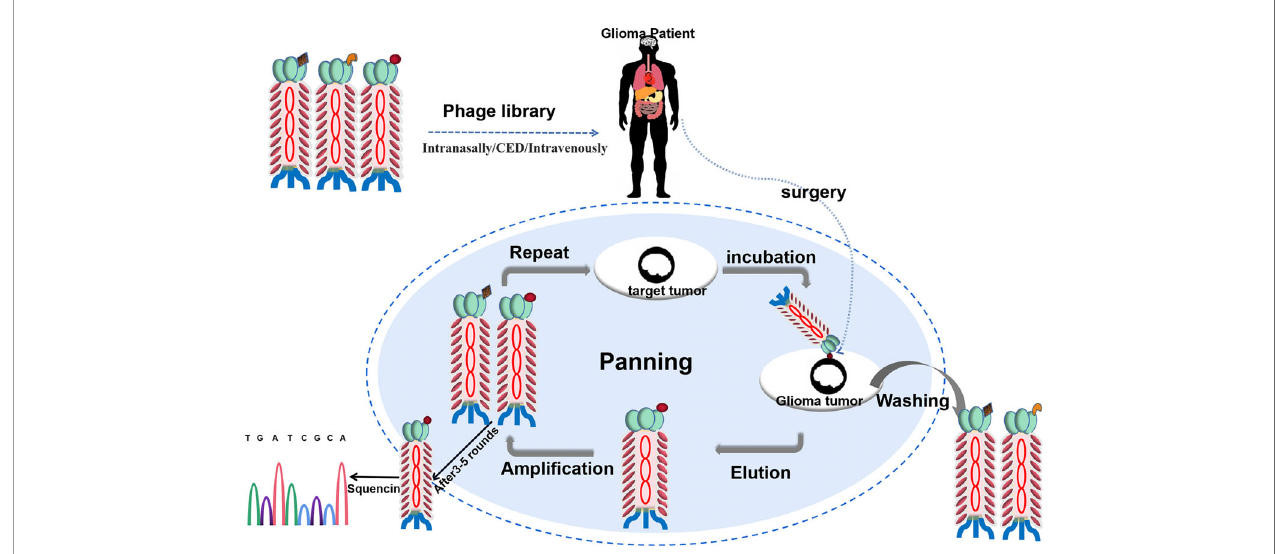
FIGURE 2 | Schematic of af fi nity-selection of targets-binding phages from a phage library for personalized therapy of glioma. An antibody phage library is administered in glioma patients. After incubation, get the tumor from the patient. The unbound phages are washed and the bound phages are collected and ampli fi ed. After 3-5 rounds, the af fi nitive phages are enriched and